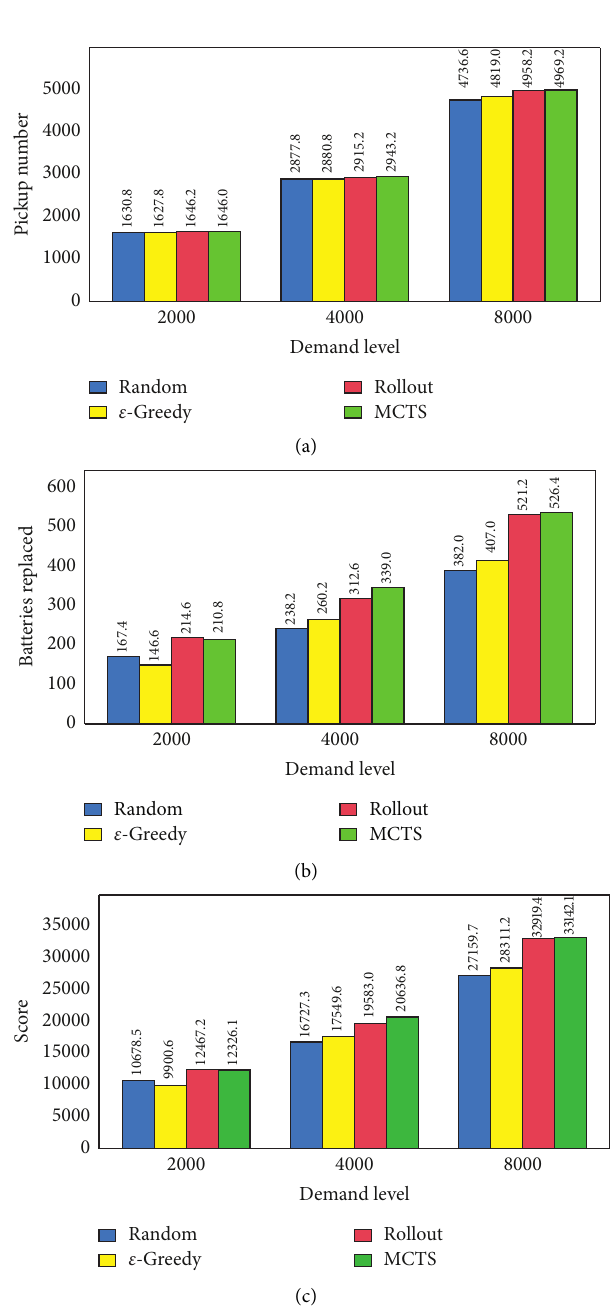
Figure 11: Evaluation of different policies at three demand levels. (a) Successful pickup number. (b) Number of replaced batteries. (c)